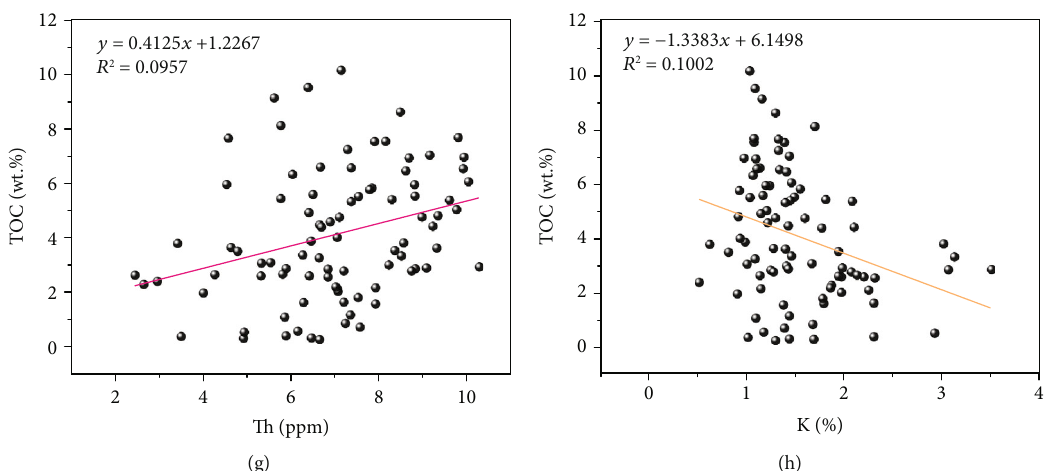
Figure 4: Crossplots between core-measured TOC and well logs: (a) RD-TOC, (b) AC-TOC, (c) DEN-TOC, (d) CNL-TOC, (e) GR-TOC, (f) U-TOC, (g) TH-TOC, and (h) K-TOC.